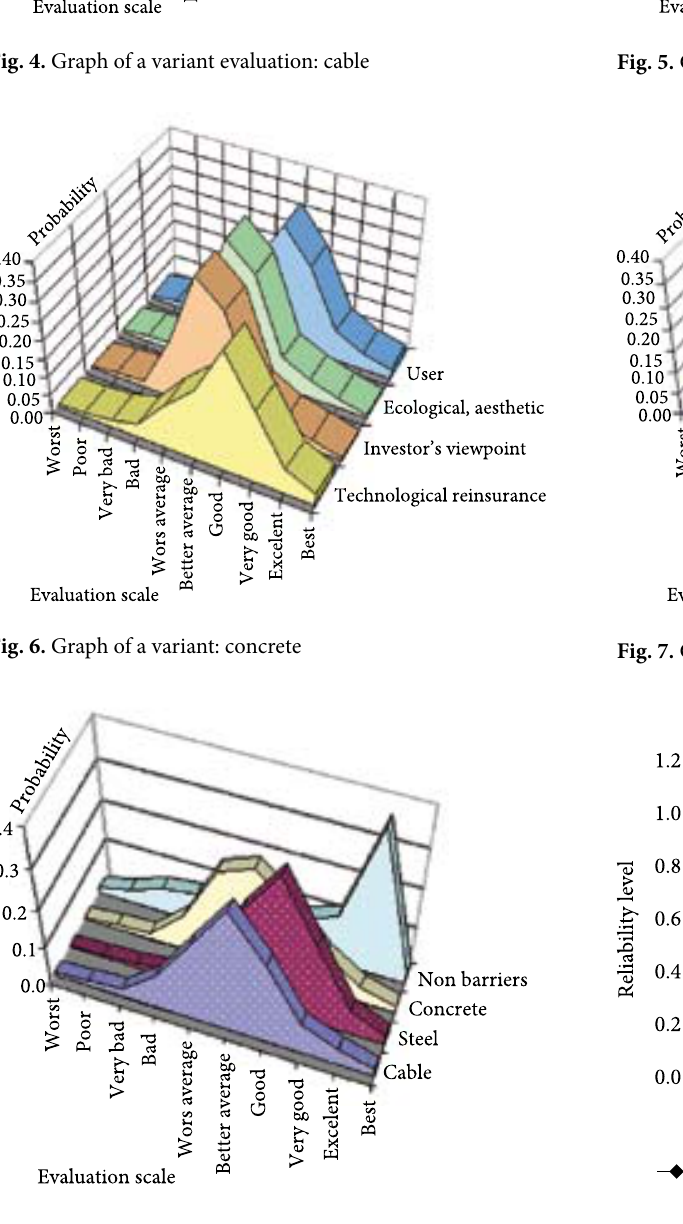
Fig. 9. Graph of a evaluation reliability level for all